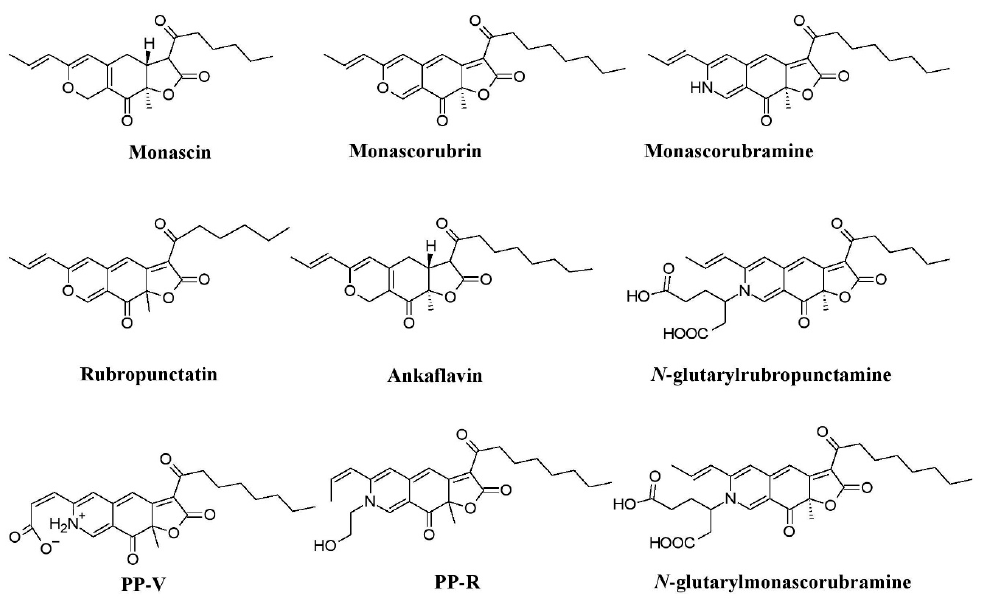
Figure 4. Monascus –like azaphilone pigments of Penicillium and Talaromyces species, re-drawn from [25,95,106].